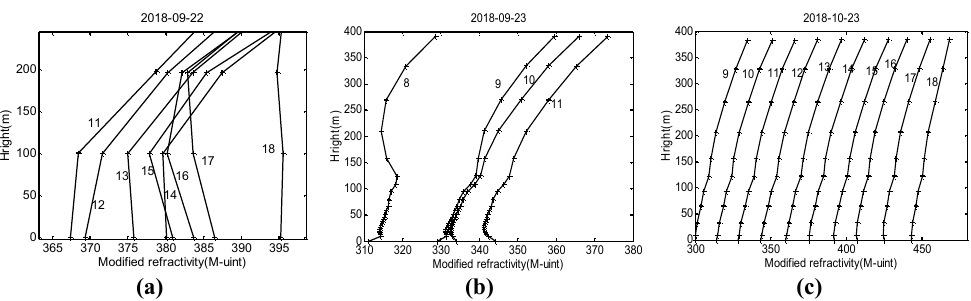
Figure 7. The atmospheric duct from the weather research and forecasting (WRF) data. The horizontal axis is the modified refractive index (M-unit), and the vertical axis is the height (m). (a) , (b), and (c) show the WRF data on 22 September 2018, 23 September 2018, and 23 October 2018, respectively. The numbers from 11 to 18 in the figures represent the local standard time for each atmospheric duct profile (i.e., 11:00 to 18:00). In order to improve the visualization of the modified refractivity profiles at different times in a day, the value of each modified refractivity profile was modified by (𝑛 − 10) × 7 M-units ( a ) and (𝑛 − 10) × 15 M-units ( b and c ) for the refractivity at n o’clock. For example, the refractivity at 11 and 18 o’clock modified 7 M-units and 56 M-units in ( a ), respectively.